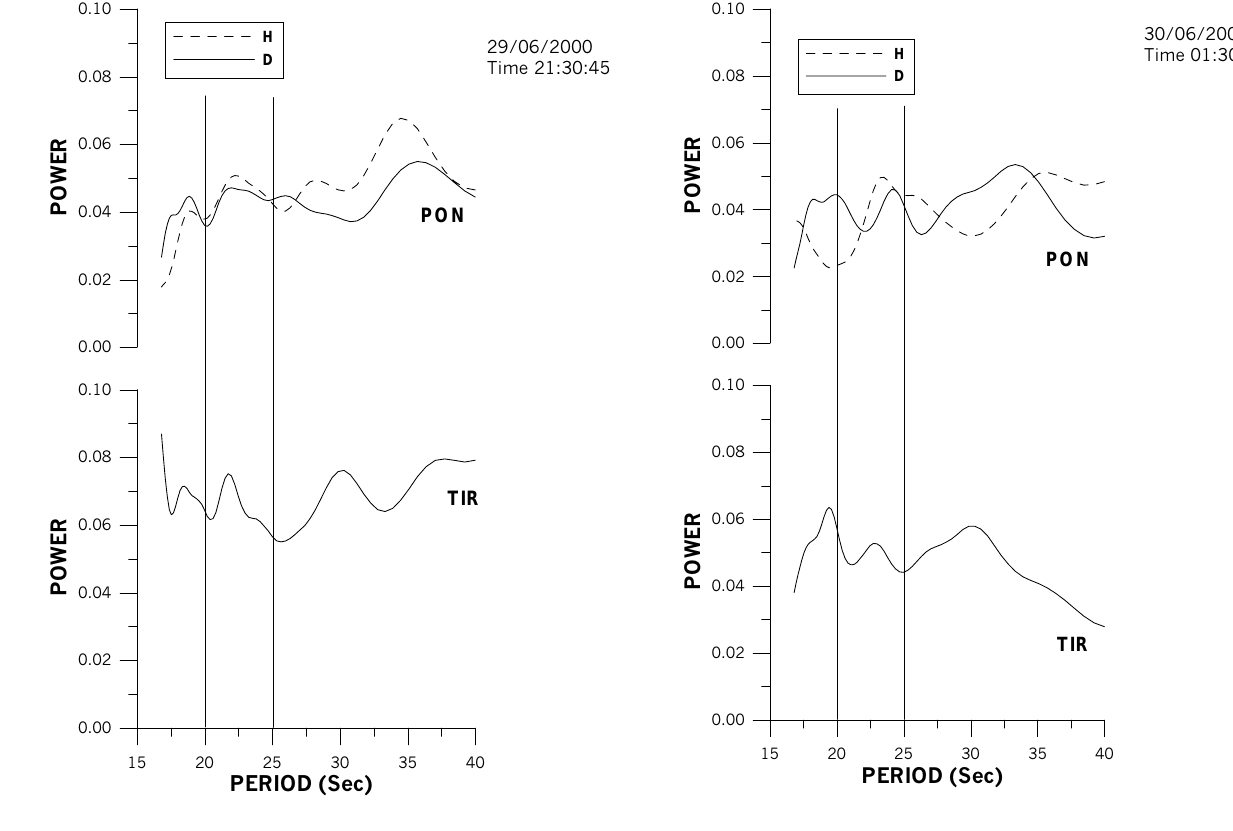
Fig. 9. The lower panel shows the power spectrum of 5 s averaged filter scintillations at Tirunalvely on the specified day and at local time. The dashed and solid curves in the upper panel respectively, show the power spectrum of H- and D-variations of ground mag- netic data of 5 s sampling interval at Pondicherry. The range of the eigen-period has been marked by the interval between two vertical lines.